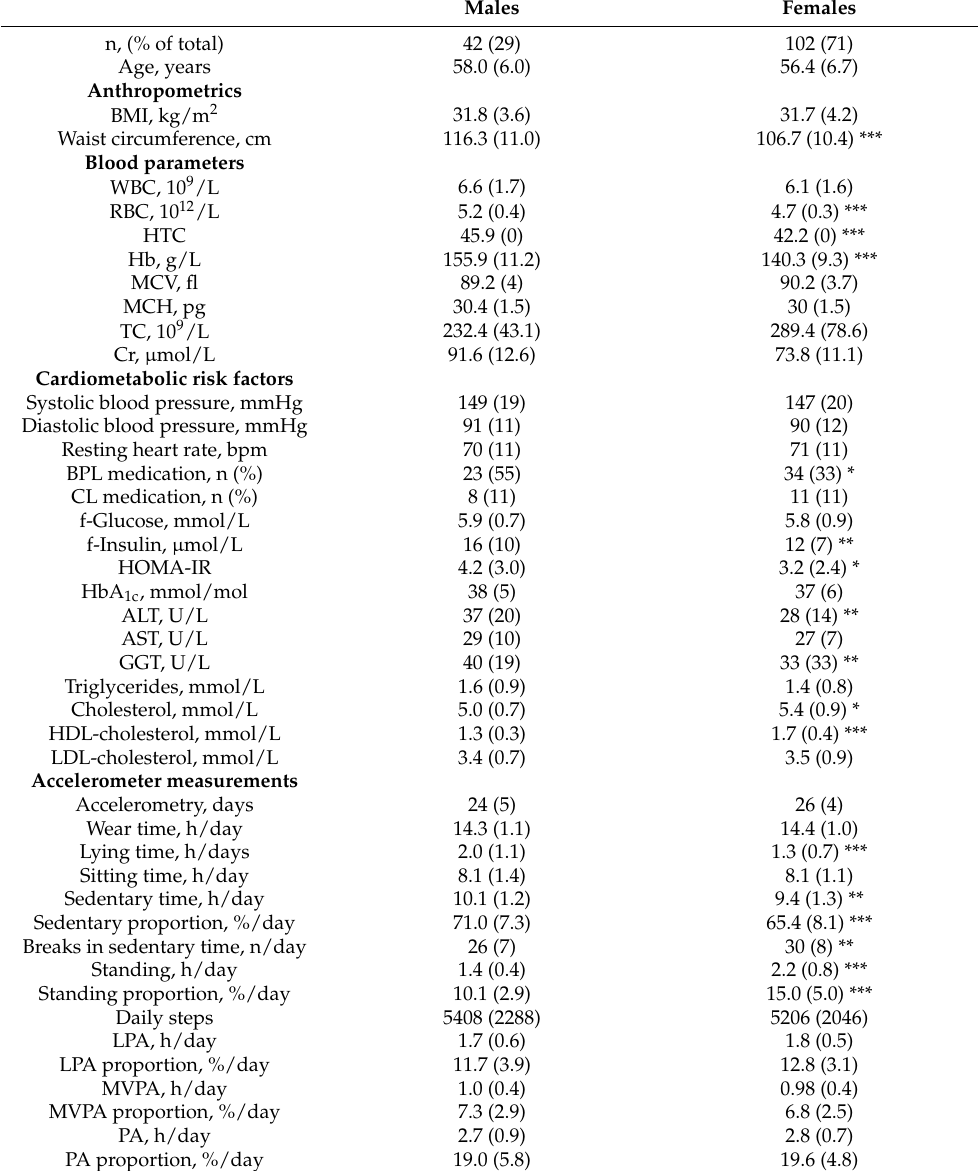
Table 1. Characteristics of the study participants by sex. The results are reported as the mean